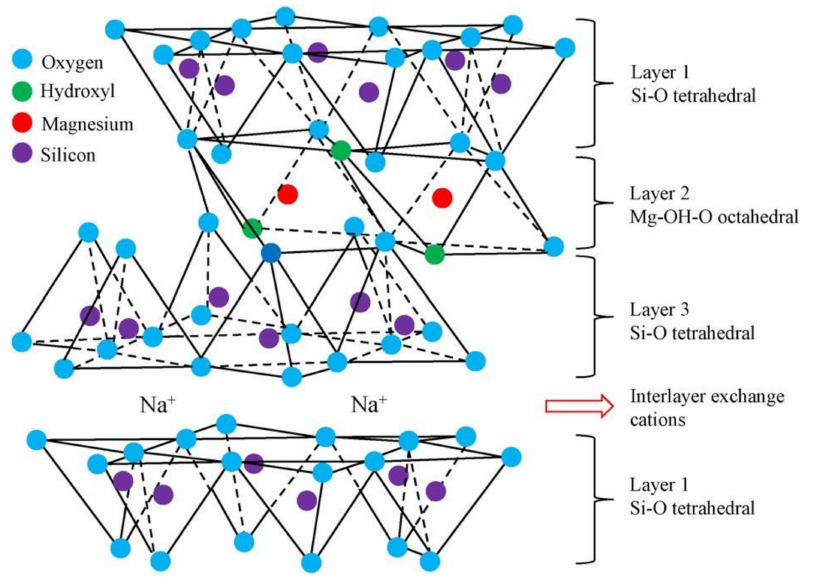
Figure 3. The microstructure of laponite